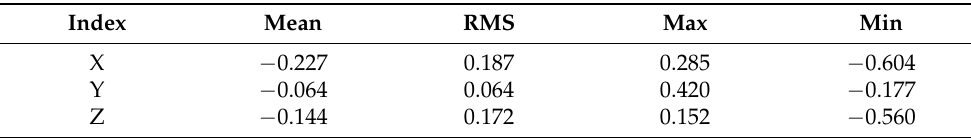
Figure 7. Initial positioning residuals distribution of ZY-3 three-line array camera. ( a ) Positioning residuals in XY planar direction; ( b ) Positioning residuals in the elevation direction. Table 2. Ground coordinates differences statistics of ZY-3 three-line array camera corresponding image points. (Unit: